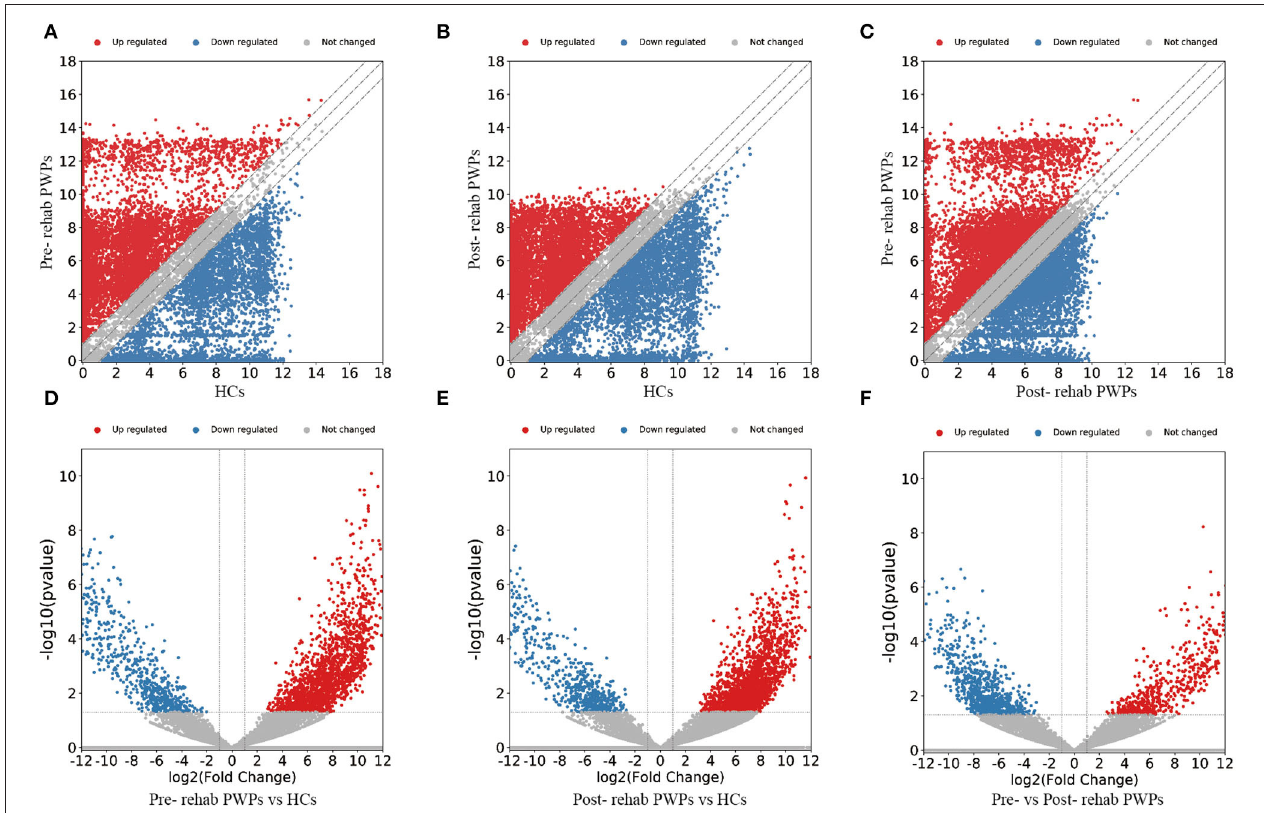
FIGURE 2 | Changes in the mRNA expression profiles of the HCs, pre- and post-rehab PWPs. The scatter plot (A) and volcanic map (D) reveal that a significant difference existed in the distribution of mRNAs between pre-rehab PWPs and the HCs. The scatter plot (B) and volcanic map (E) reveal that a significant difference existed in the distribution of mRNAs between Post-rehab PWPs and the HCs. The scatter plot (C) and volcanic map (F) reveal that a significant difference existed in the distribution of mRNAs between pre- and post-rehab PWPs. Red represents upregulation, while green represents downregulation. Pre-rehab, pre-rehabilitation; Post-rehab, post-rehabilitation; PWPs, patients with Parkinson’s